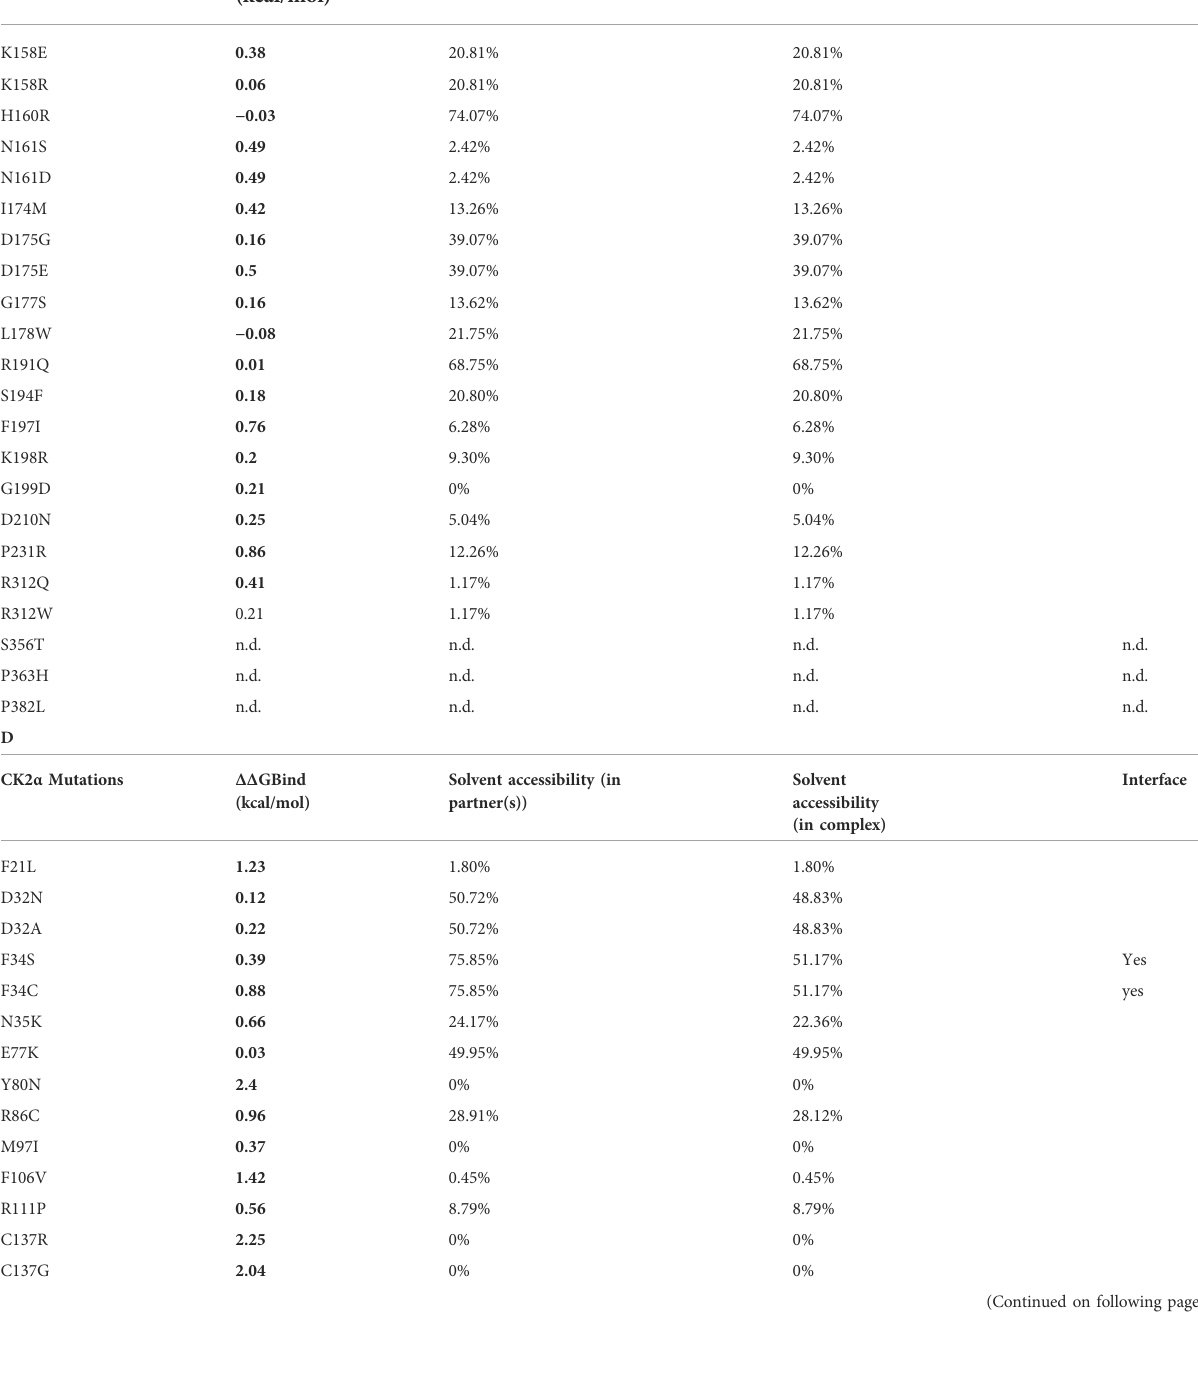
TABLE 8 ( Continued ) Binding free energy changes between the wild type and mutant complexes. ΔΔ G values were predicted using BeAtMuSiC (Dehouck et al., 2013). For this structure based approach, the binding of one CK2 α chain (chain C) to the CK2 β dimer (chains A/B) was evaluated, using the CK2 holoenzyme structure (PDB_ID 4DGL; (Lolli et al., 2012)) as input fi le. Mutations which cause an increase of binding free energy of more than 2.0 kcal/moluponmutation arehighlightedinredinthe fi rstcolumn.Positive ΔΔ Gvaluesindicatethatthemutation decreasesbindingaf fi nity(inred), and negative ΔΔ G values indicate that the mutation increases binding af fi nity (in green). BeAtMuSiC (Dehouck et al., 2013) identi fi es a residue as interface residue if its solvent accessibility in the complex is at least 5% lower than in the unbound form. (A) ΔΔ G values for previously experimentally characterizedCK2 α variants(Raafetal.,2011).(B) ΔΔ GvaluesforpreviouslyexperimentallycharacterizedCK2variantsorcorrespondingexchangesina CK2 β -derived cyclic peptide including CK2 β residues Arg186 to His193 (Laudet et al., 2007). (C) ΔΔ G values for OCNDS-related CK2 α variants. (D) ΔΔ G values for POBINDS-related CK2 β